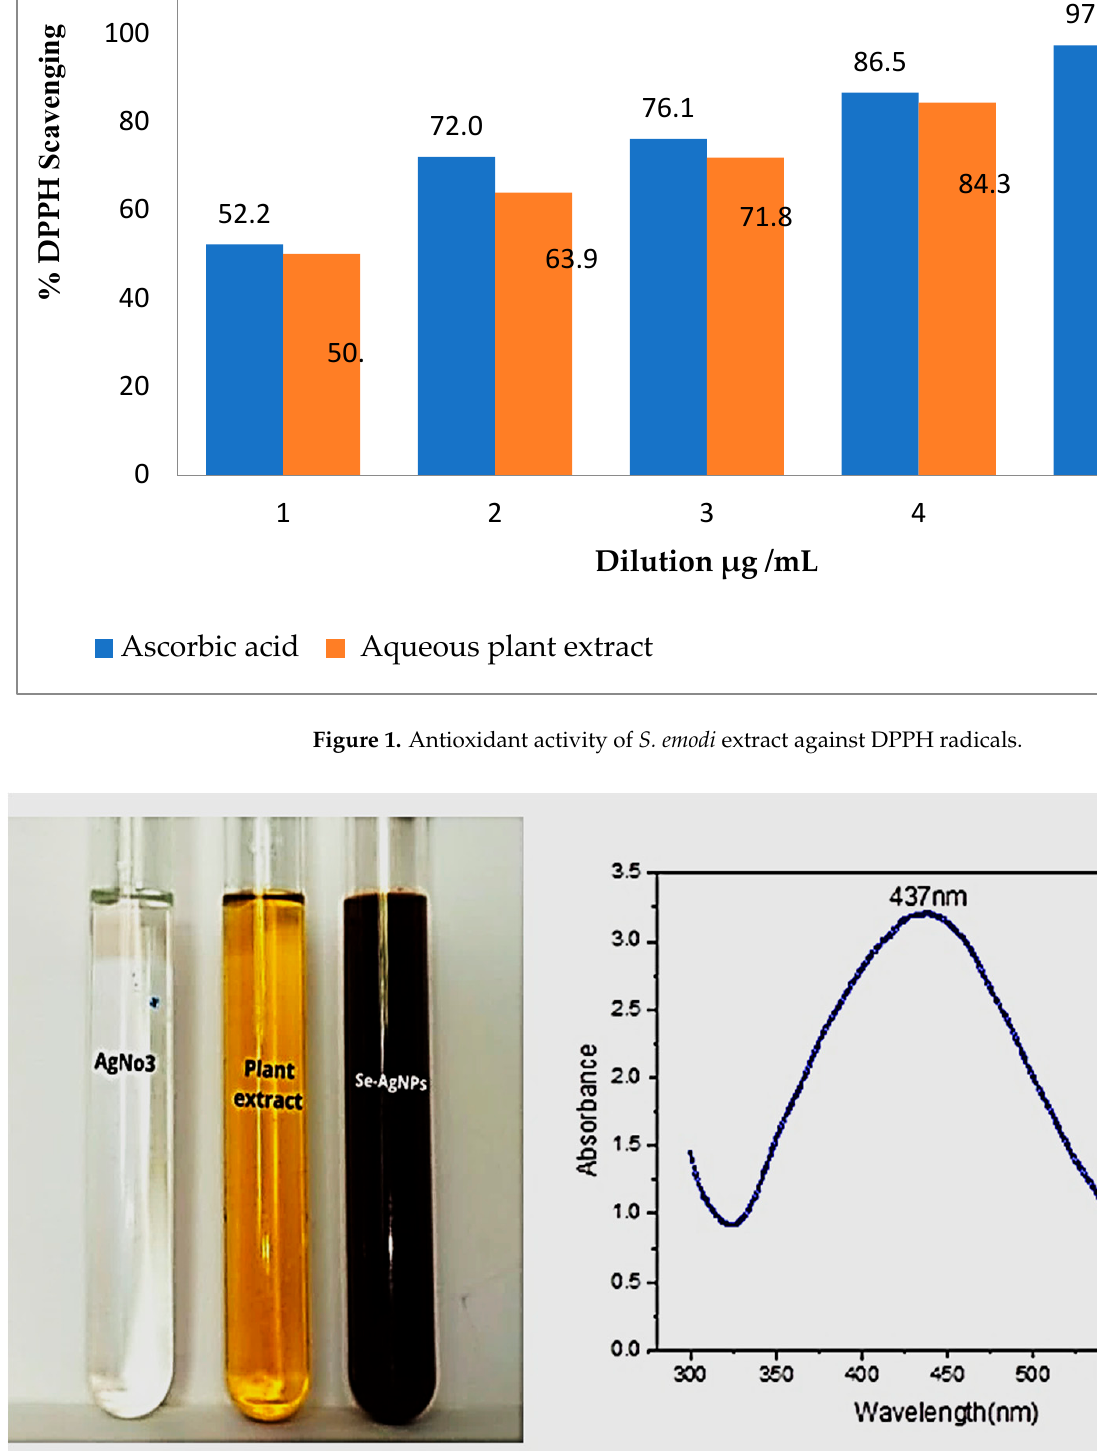
Figure 1. Antioxidant activity of S. emodi extract against DPPH radicals.